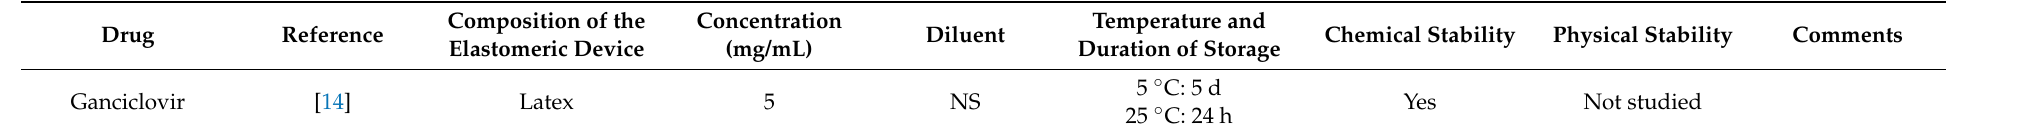
Table 8. Stability of antivirals in elastomeric